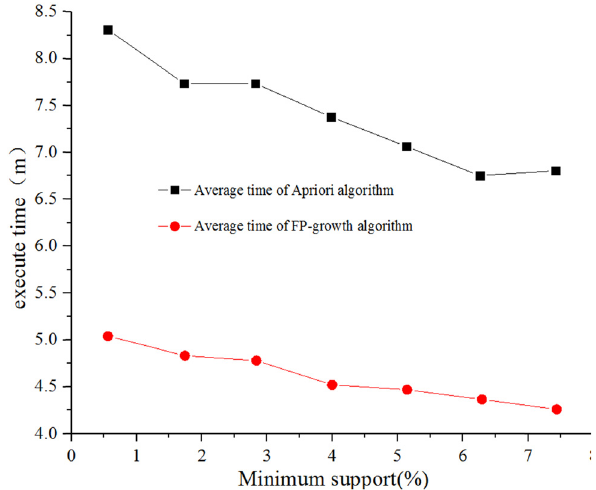
Figure 4: Average mining time of the two algorithms.